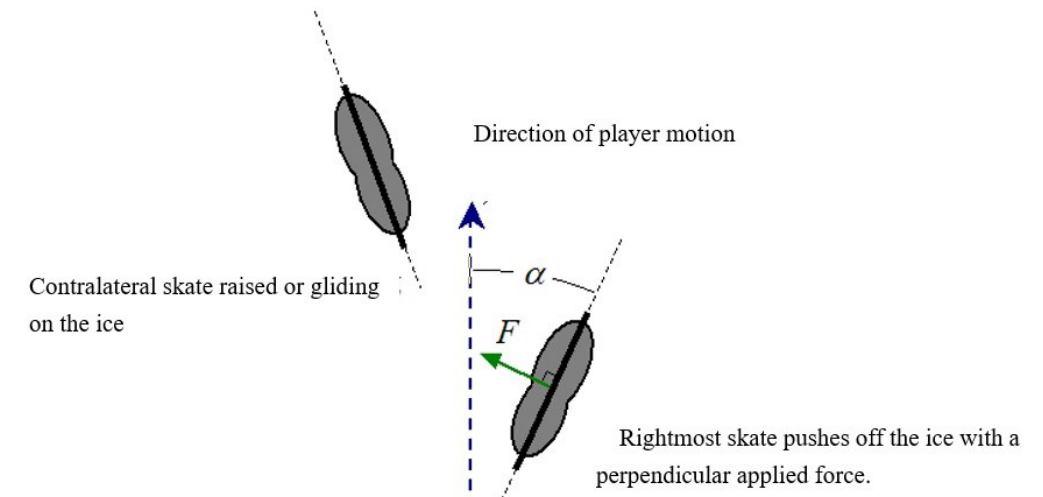
Fig. 2. The push off in ice skating. To push off the ice with greater forward force, an ice hockey player must increase the angle α that increases the component of force in the direction of motion. Where F is applied force. Image used courtesy of Alain Haché (Professor adjoint, Universite de Moncton)